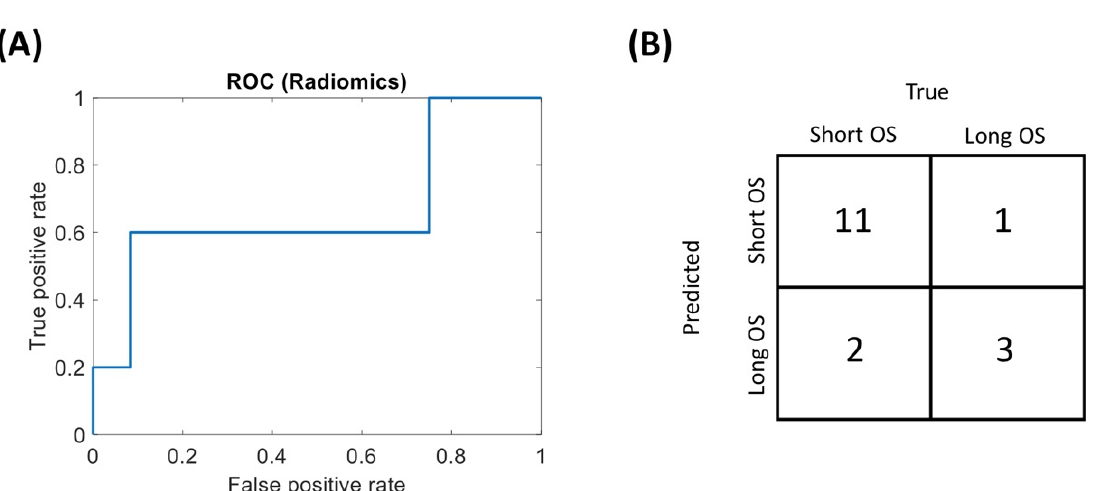
Figure 2. Performance of the radiomic signature on the test set. ( A ) Receiver operating characteristics (ROC) curve of the signature. ( B ) Confusion matrix.